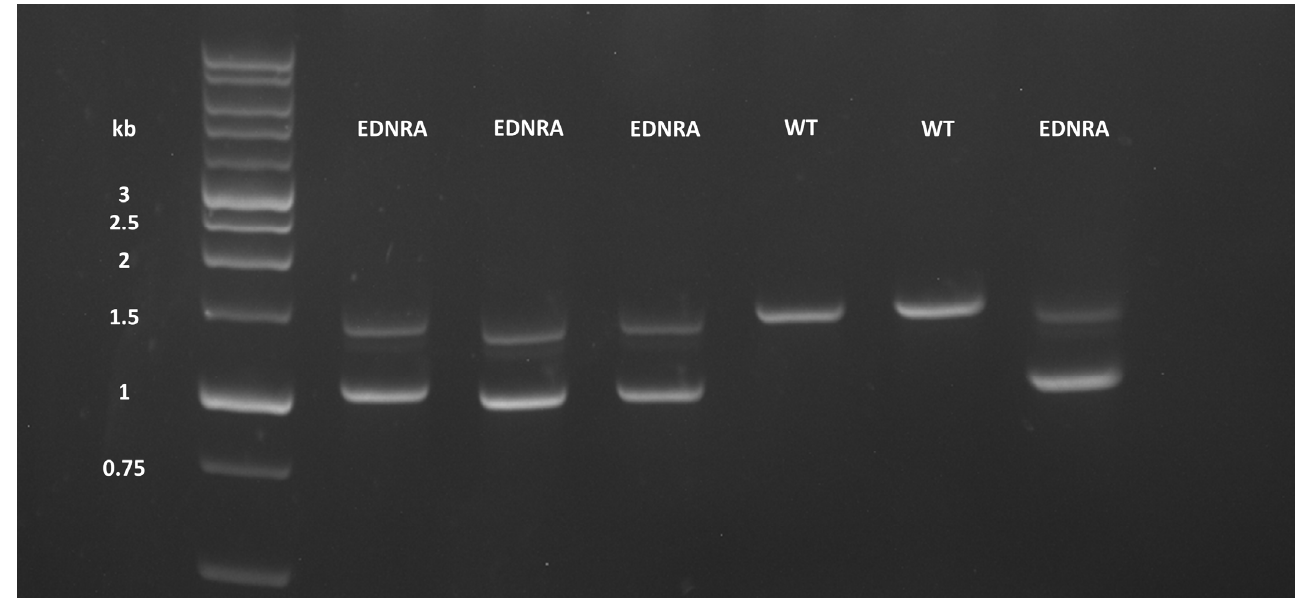
Figure 1. Exemplary results of genotyping of six rats’ DNA. Heterozygous EDNRA rats showed wild-type bands and mutant bands (1504 bp and 1092 bp) as verification of deletion. Marker on left side, kb = kilobase pairs.